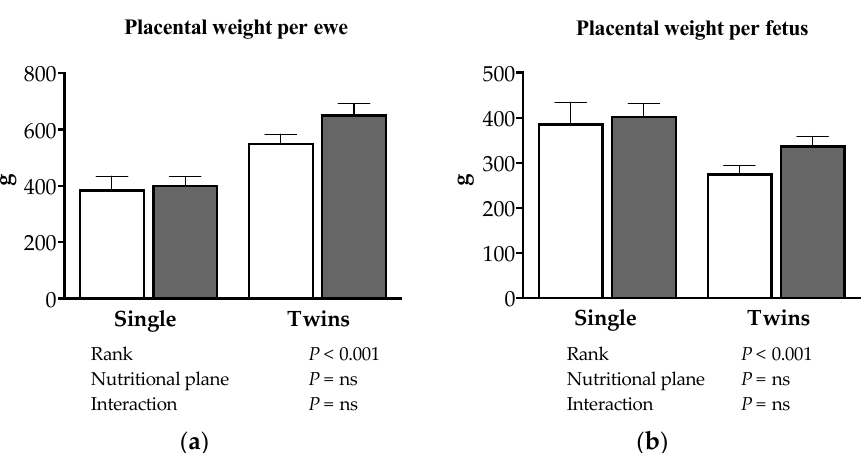
Figure 2. ( a ) Placental weight per ewe. ( b ) Plcental weight per fetus. Placental outcome at 140 days of pregnancy in ewes bearing single and twin fetuses, maintained under adequate or deprived nutritional planes. The empty bars correspond to unsupplemented animals. The gray bars correspond to animals fed with natural pasture plus concentrate supplementation. The corresponding effects and their statistical significance are presented as footnote in each figure.